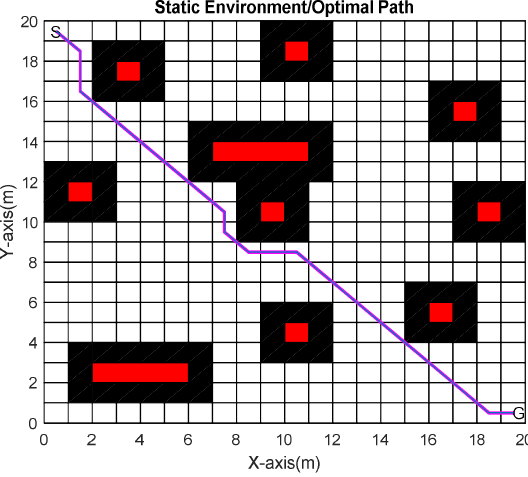
Fig. 18. Best Path found by Modified ACO for Experiment 1.